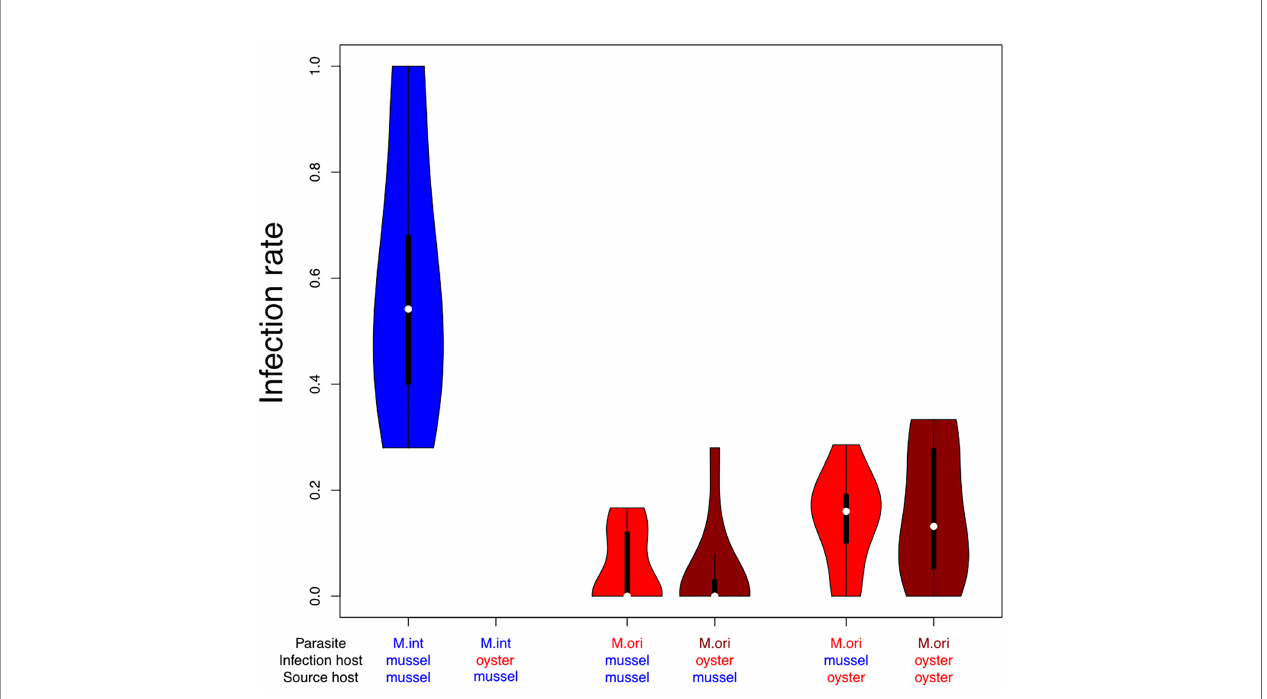
FIGURE 5 | Infection rates of Mytilicola intestinalis (M. int, blue) and Mytilicola orientalis (M. ori, red, dark red) originating from mussel or oyster source hosts infecting mussels or oysters as infection hosts. Violins show the range of the observed data with violin width representing the frequency distribution of values. Box and whiskers give the 50 and 95 percentile, and white dots within boxes show the median. Infection rates of M. intestinalis were highest in mussels, whereas none of the experimental M. intestinalis infections were successful in oysters. Mytilicola orientalis had lower infection rates in both hosts combined than M. intestinalis in its only host. When originating from oysters M. orientalis showed a higher infectivity in both hosts, but they were still less successful than M. intestinalis in infecting